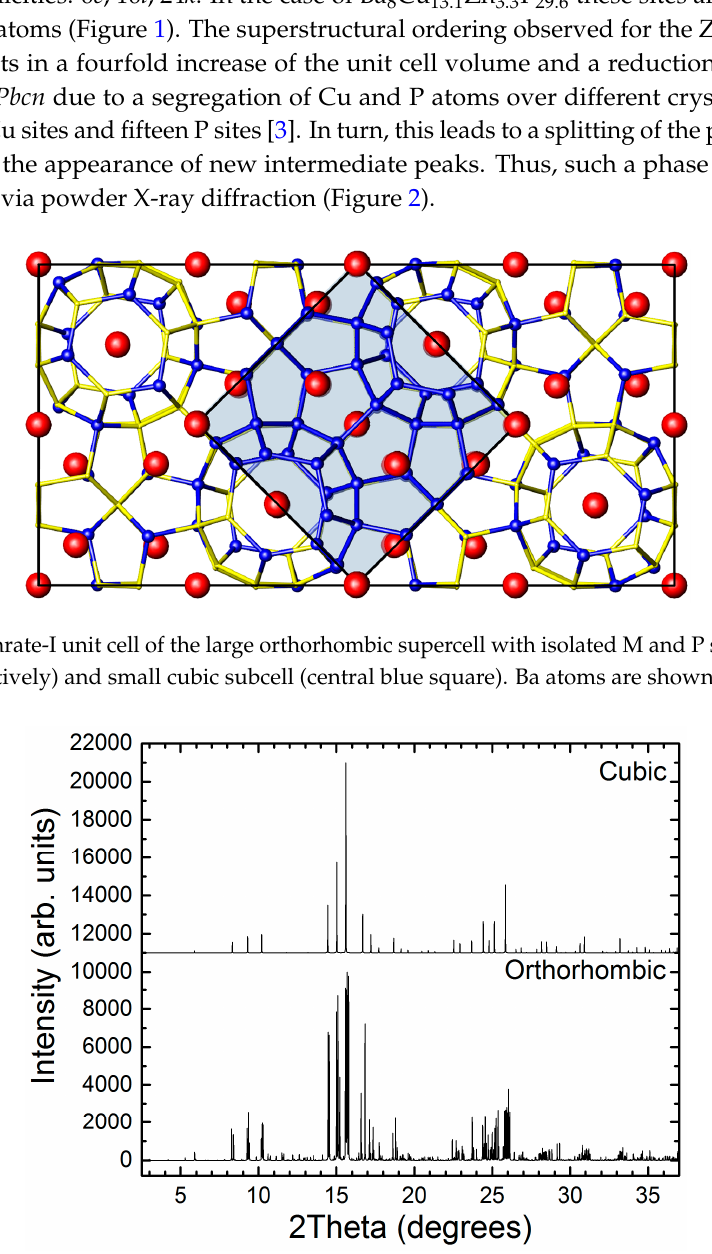
Figure 2. Calculated powder diffraction patterns ( λ = 0.72775 Å) for cubic and orthorhombic structures of clathrate-I with identical composition Ba 8 Cu 16 P 30 .